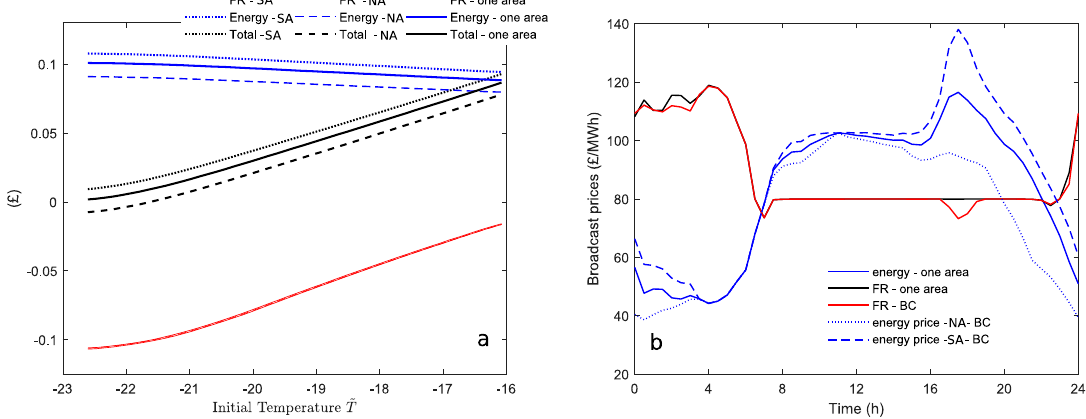
Figure 12. ( a ) Cost breakdown for individual TCLs with different intimal temperature 𝑇(cid:3560) . Solid lines refer to the UC scheduling with a one area approach. ( b ) Energy prices and FR prices at the equilibrium solution. Dashed and dotted lines refer to the DCS BC for the NA and SA, respectively.